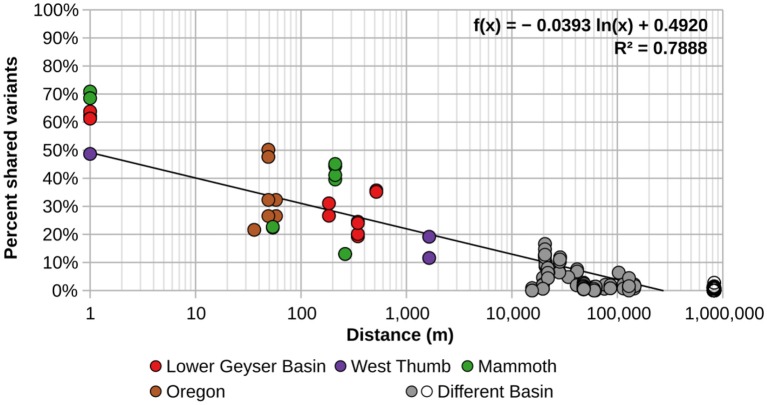
Percentage of shared A-like Synechococcus psaA gene segment HFS2 variants relative to separation between pairs of springs sampled. Each circle represents a pair of springs, with colored circles representing pairs from within the same basin. Gray circles represent pairs of springs from different basins within and around Yellowstone, while open circles represent comparisons between springs in Oregon with springs in and around Yellowstone National Park. The black trend line was calculated from all comparisons.